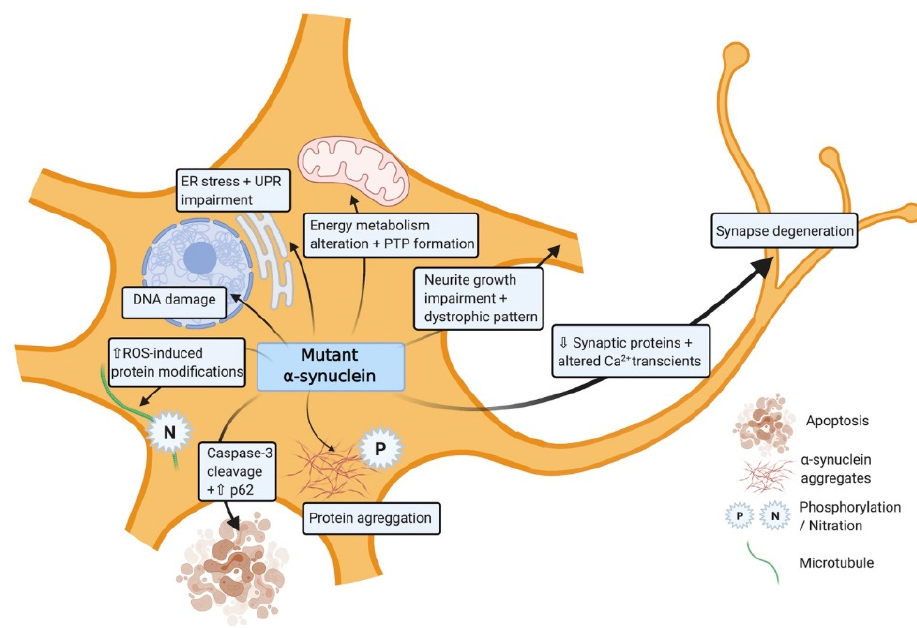
Figure 2. Induced pluripotent stem cell (iPSC)-derived dopaminergic neurons modelling the role of mutant SNCA . The illustration shows the impact of the mutated α -synuclein in different cellular processes within the cell.